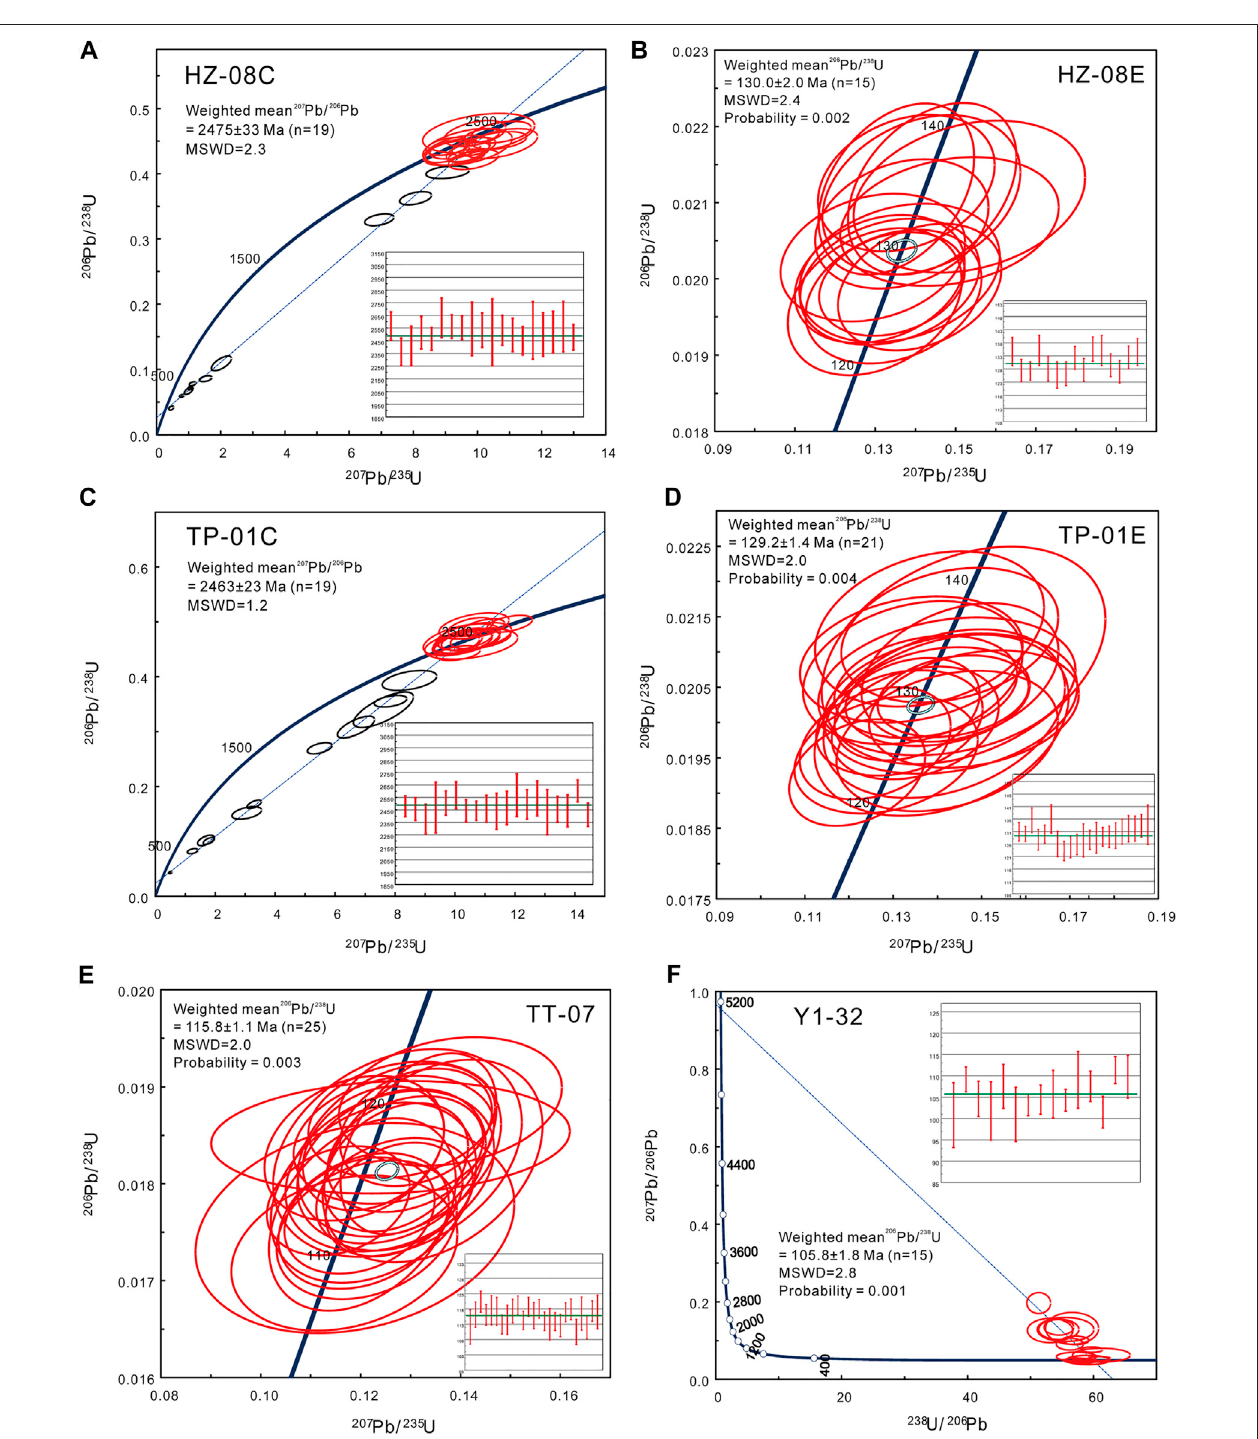
FIGURE 5 | Zircon LA-MC-ICP-MS U-Pb Concordia diagrams ofthe Huaibei-Linhuan intrusive rock samples: (A) inherited zircon cores from Haizi diorite porphyry (HZ-08); (B) zircongrowthrimsfromHaizidioriteporphyry(HZ-08); (C) inheritedzirconcoresfromTaipingdiorite(TP-01); (D) zircongrowthrimsfromTaipingdiorite(TP- 01); (E) Qingdong microgabbro (TT-07); (F) Yuandian-1 dolerite (Y1-32). from lower-continental crustal (LCC)-derived ones, because (Liu S.-A. et al., 2010). Our adakitic (quartz-)diorite-granodiorite altered oceanic crust (with MORB-type LREE depletion and Sr samples have elevated Sr/La ratios ( Figure 11A ), indicating a enrichment by seawater) has much higher Sr/La than the LCC slab-derived origin. The slab-derived origin is also supported by